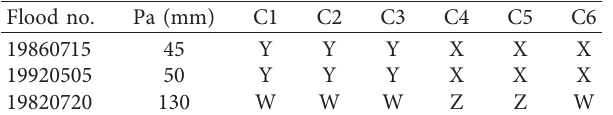
o ), and comparison between CR and accumulated rainfall ( P Table 9: Results of modeled warning. Flood no.